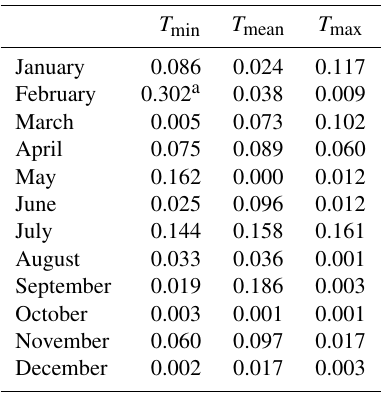
Table 8. Relationship ( R 2 ) of maximum snow cover fraction (%) and monthly T min , T mean and T max from 2002 to 2013.